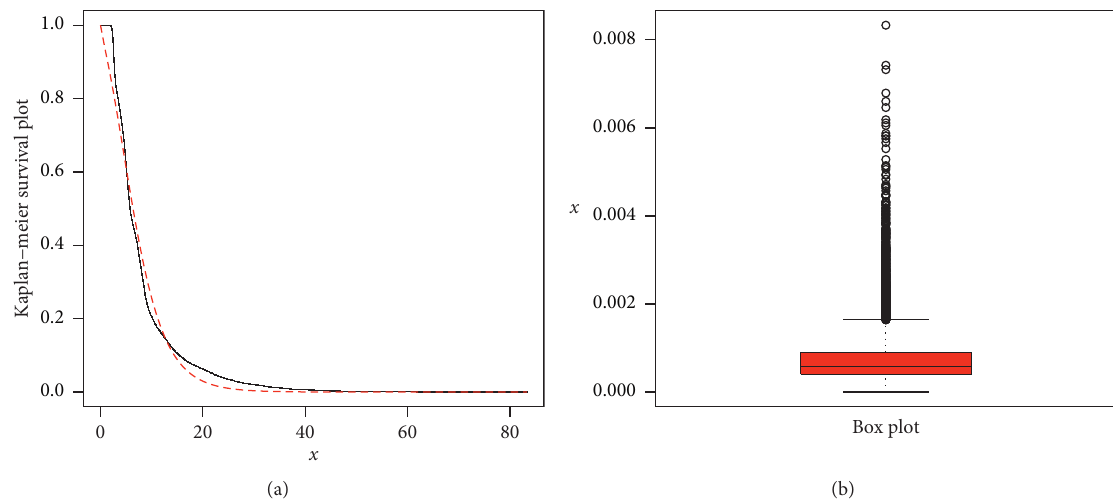
Figure 10: Kaplan–Meier survival plot of the ETX-Weibull distribution and box plot of the automobile insurance claim data